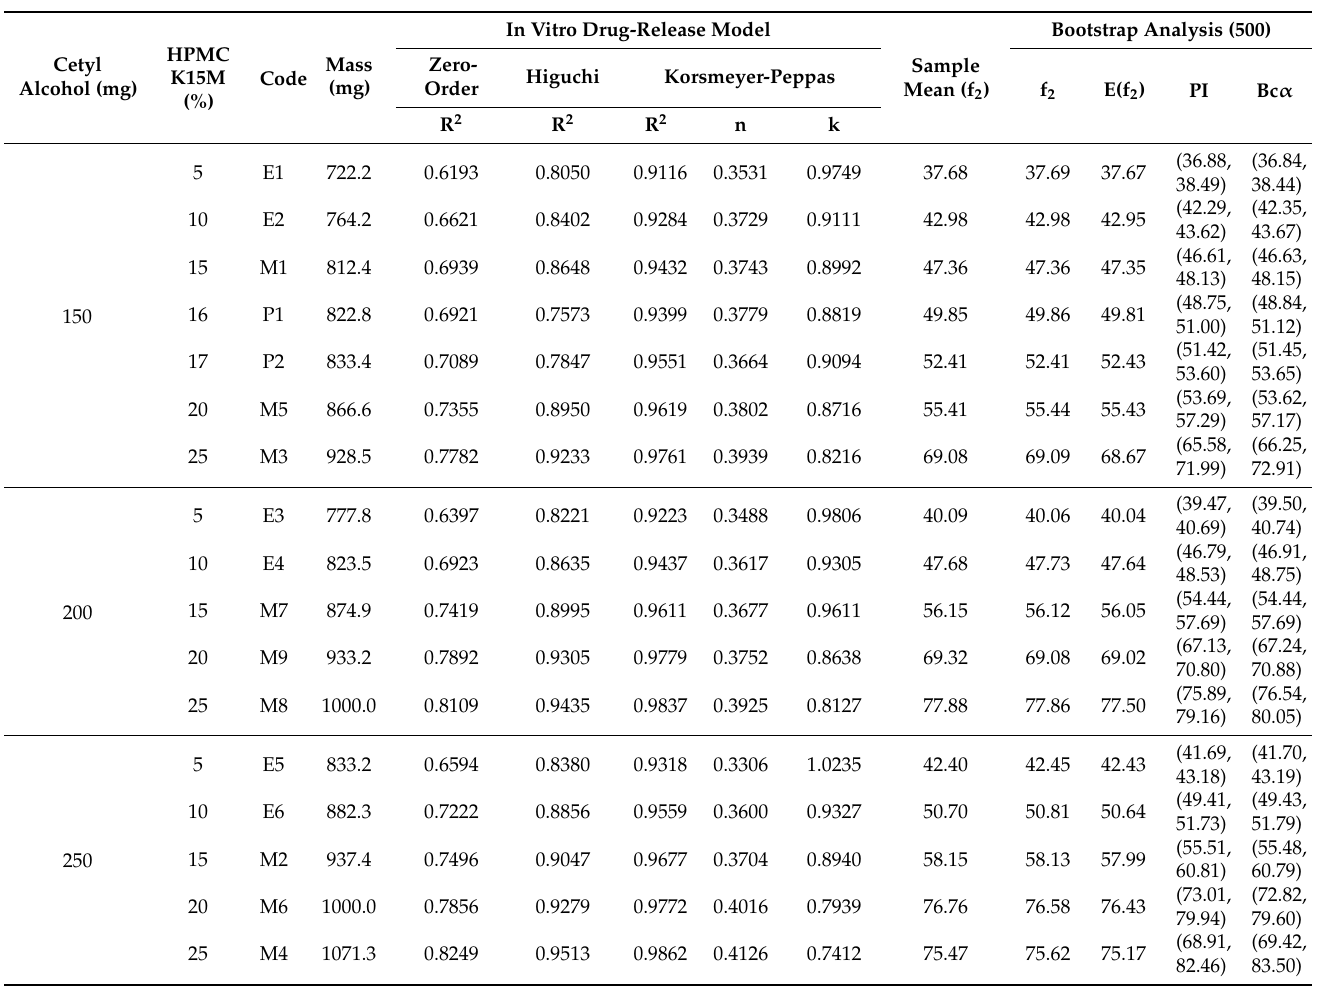
Table 5. Summary of tablet weights for all designed formulations, the fitting of the release kinetics models, and the results of bootstrap analysis (90%